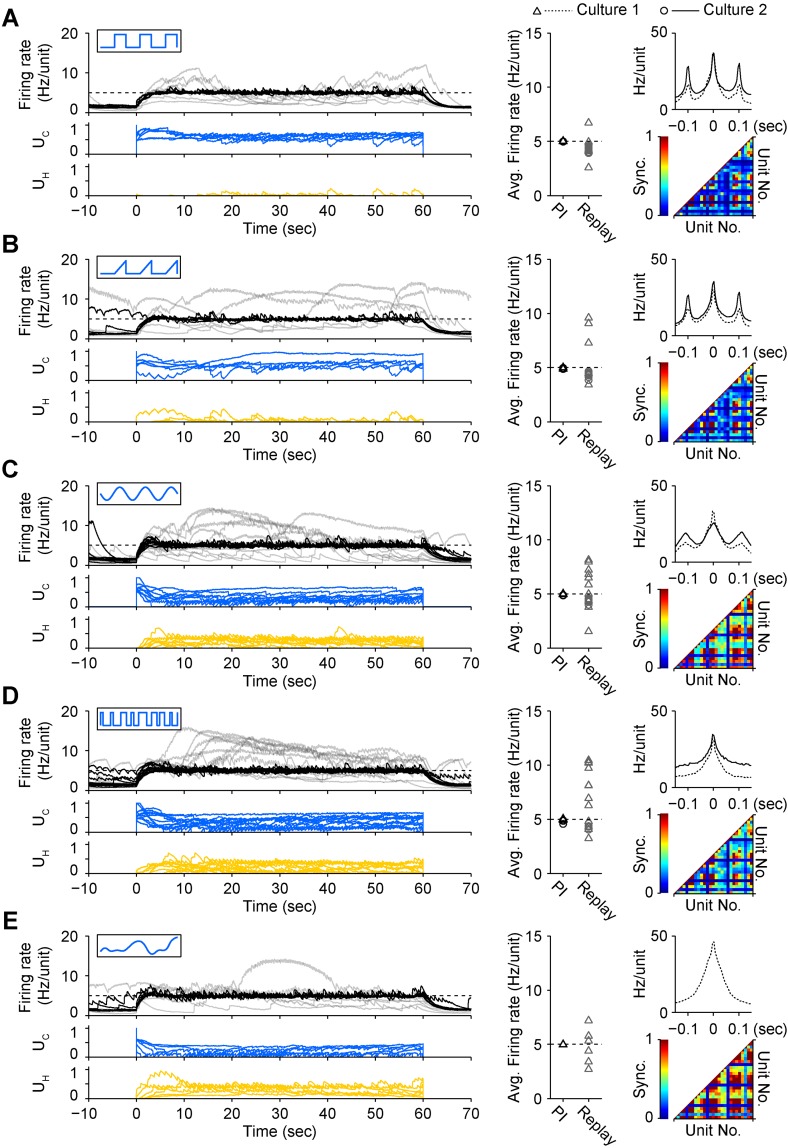
A diverse set of optical input signals can be used to clamp network firing rate, and accurate firing rate control requires closed-loop stimulation.(A) Left, network firing rates during closed-loop control (black) and during replay of closed-loop control signals in open-loop (grey), along with corresponding control inputs UC (blue) and UH (yellow). These time series data were derived from culture 1. Note that in all instances, open-loop replay of input signals recorded from previous successful closed-loop control failed to clamp firing levels and resulted in erratic activity levels over the control epoch. Middle, time-averaged firing rates for both cultures during closed-loop control (black) and during subsequent replay of control signals in open-loop (grey). Right, average unit-to-unit cross-correlogram for both cultures (top, bin = 5 ms) and unit-to-unit synchronization structure for culture 1 (bottom) during optogenetic feedback control. Synchronization was defined as,Synci,j=Ncc(Ni2+Nj2)/2,where Ncc is number of correlated events within ± 10 ms, and Ni and Nj are the number of spikes from units i and j used to calculated the cross-correlogram.(B) Same as (A) for triangle optical stimuli modulated according to.Pulse freq.465 nm=10 Hz,Rising slope.465 nm=0.22 mWms·mm2,Peak power 465 nm=13.4UC mWmm2.(C) Same as (A) for sinusoidal optical stimuli modulated according to.Optical power 465 nm=13.4UCsin(2π10t) mWmm2.(D) Same as (A) for pseudo-random binary sequence of optical pulses modulated according to.Update freq.465 nm=150 Hz,Peak power 465 nm=13.4UC mWmm2.(E) Same as (A) for continuous optical stimuli modulated according to.Optical power 465 nm=13.4UC mWmm2.Each protocol was performed in the same culture.Periodic stimuli (panels A–C) were applied at 10 Hz so that the periodicity of evoked activity would be apparent in the correlation functions. In all cases, the 590 nm light was modulated according the standard control scheme (Equation 10 of ‘Materials and methods’). Note that each input type evokes a unique correlation and synchronization structure while still achieving accurate firing rate control.